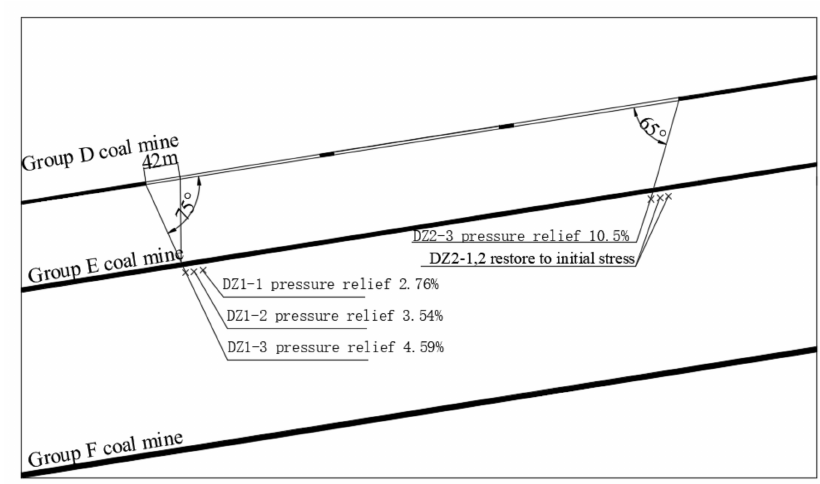
Figure 13. Pressure-relief range of Group E coal seam.